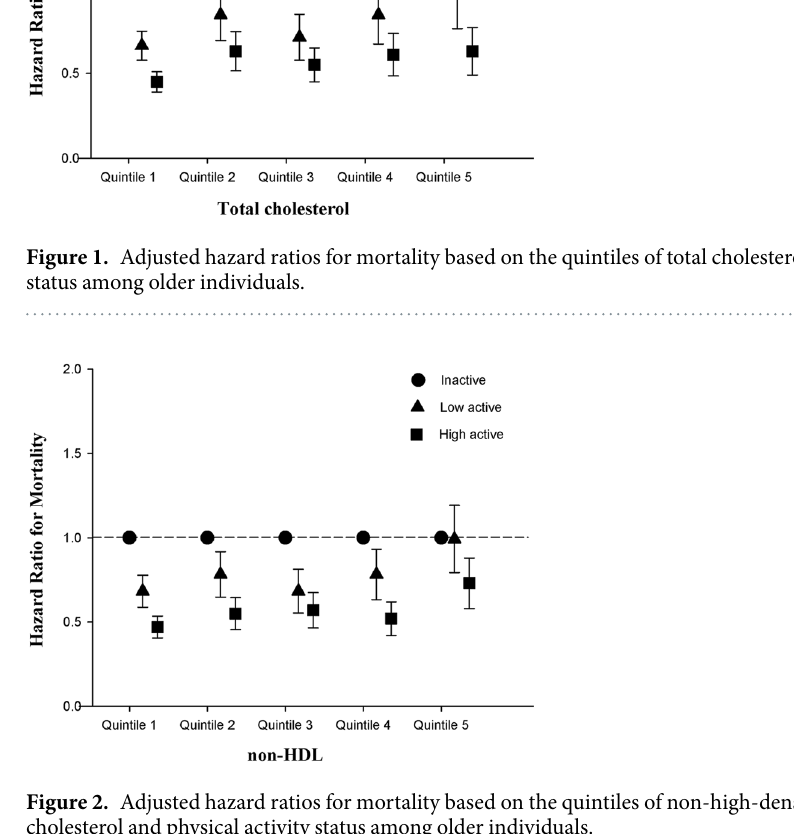
Cox Regression Analysis Crude HR (95% CI) P